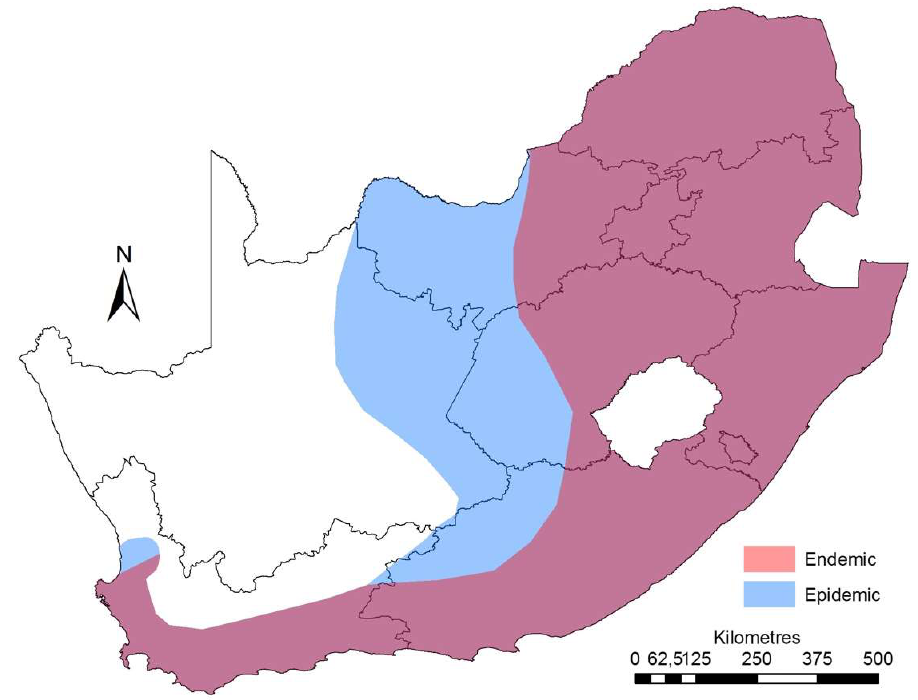
Figure 1. Endemic (red) and epidemic (blue) areas of bovine anaplasmosis disease coverage in South Africa based on historical distribution of vector ticks and areas where the disease has been reported.